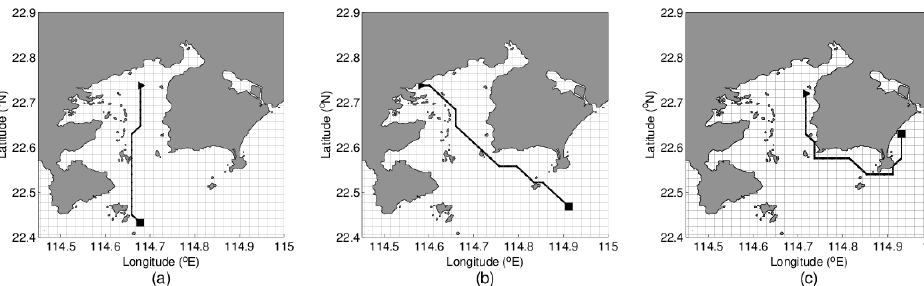
Figure 9. The predicted paths with consideration of time-varying currents for Cases 1 ( a ), 2 ( b ), and 3 ( c ). Table 7. The travel times in the three cases with time-varying ocean currents.